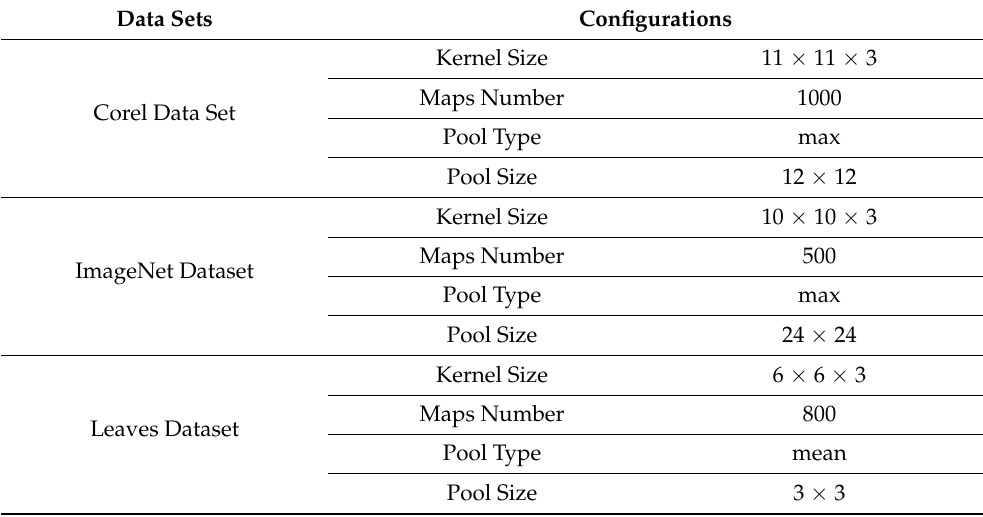
Table 2. Main configurations of SCSA on